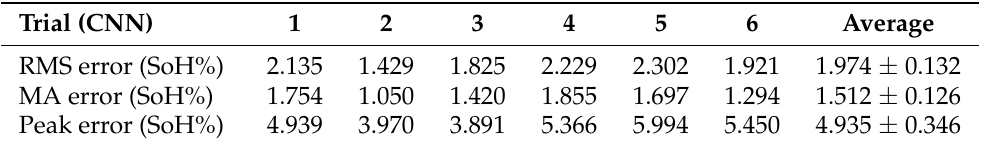
Table 1. 6-fold cross-validated RMS, mean absolute (MA), and peak prediction errors of state of health estimation for the convolutional neural network